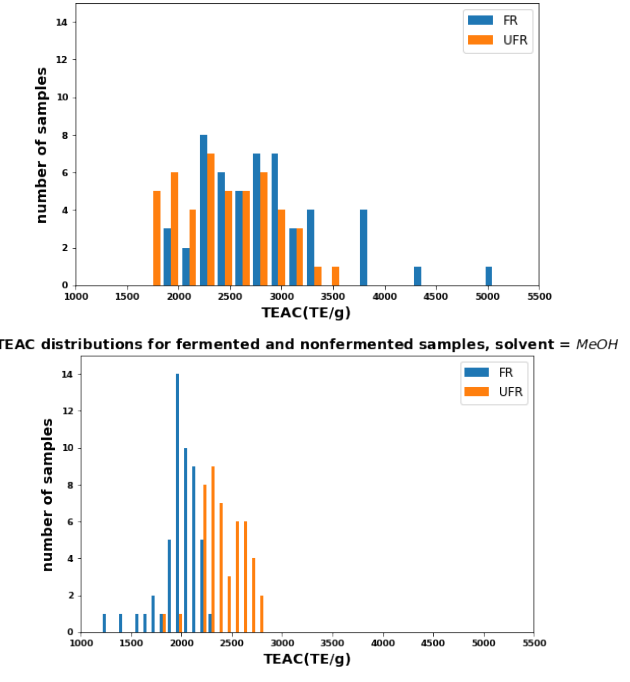
Figure 3. Distributions of TEAC for FR and UFR using water ( top ) and methanol ( bottom ) as solvents.